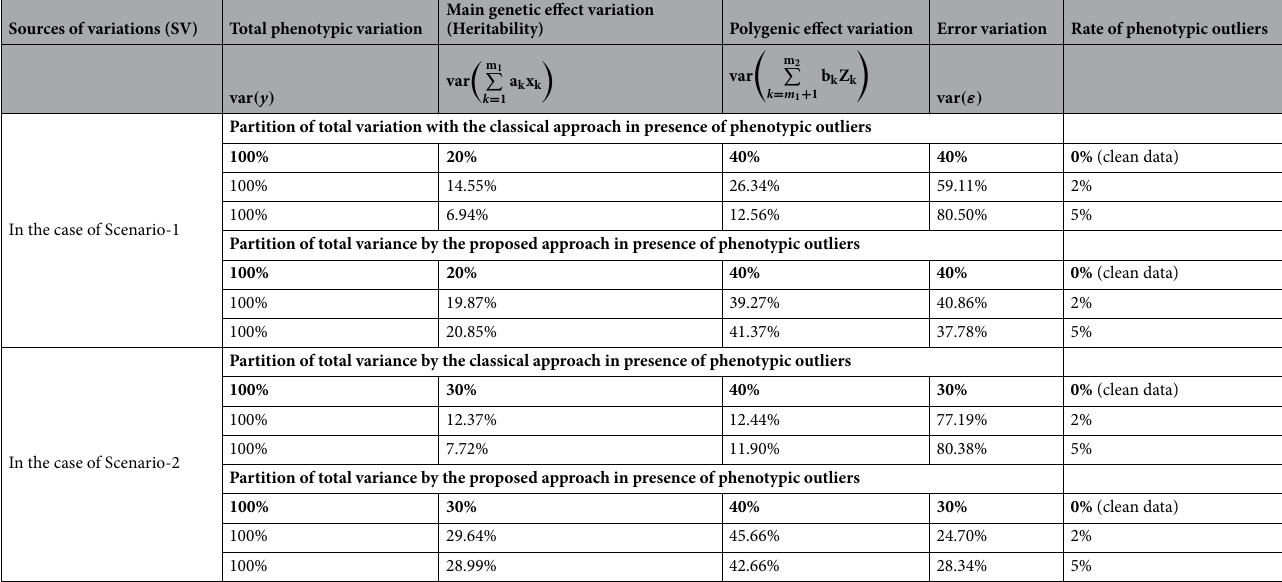
Table 1. Consequence phenotypic outliers on the partition of total variations with the classical and proposed approaches. The bold text indicates the partition of total variation for the clean